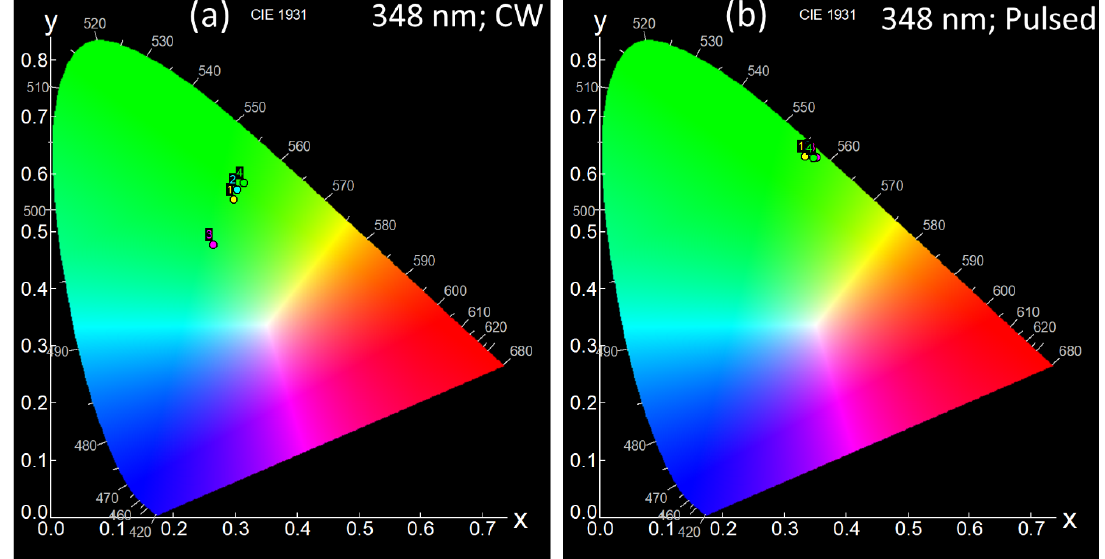
Figure 8. CIE 1931 chromaticity diagram of the Ho-SiAlON ceramics samples ( a ) upon 348 nm CW excitation ( b ) upon 348 nm pulsed excitation. Corresponding CIE coordinates are listed in Table 3. The emission modulation under CW and pulsed excitations result in different emission